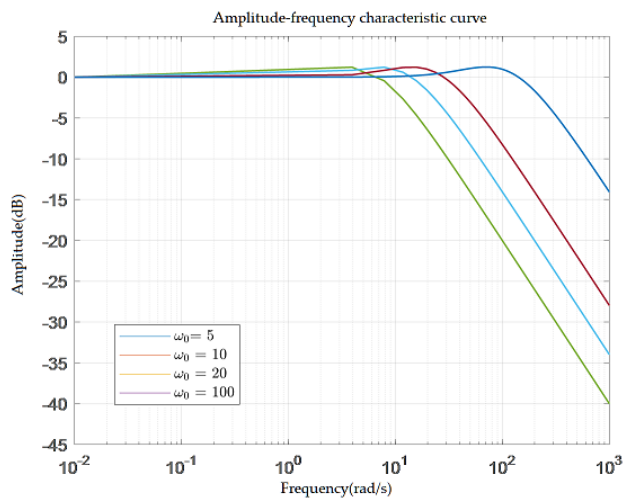
Figure 12. Measurement of noise amplitude-frequency.